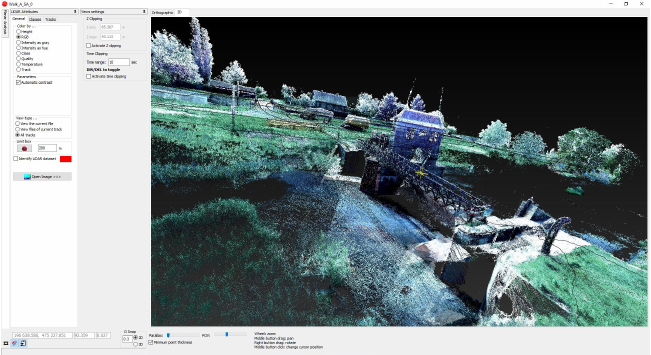
Figure 18. Viewing LiDAR point clouds obtained by scanning the Sânmihaiu Roman Lock (RGB).